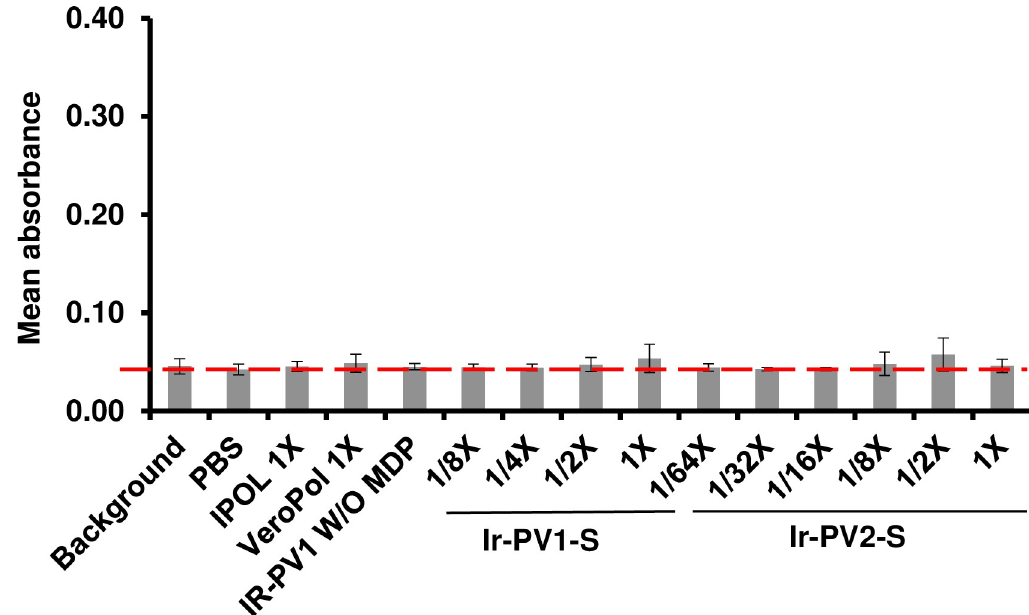
Fig 6. ELISA analysis of Wistar rat sera for MDP peptide reactivity. Sera from immunized rats were tested for anti-peptide antibodies using 96-well plates, which were coated with 5 ng DP1. Mean absorbance values of quadruplicate wells were plotted with standard deviations (mean values from 8 biological replicates per group). Values from wells probed without sera (Background or baseline, indicated with a red dotted line) or sera from rats immunized with either PBS, a 1 × human dose of IPOL, VeroPol, or IR-inactivated PV1-S without MDP were included as controls. Mean absorbance values from wells probed with sera from Wistar rats immunized with indicated doses of PV1-S and PV2-S are shown here. No significant differences were observed between any of the groups tested above. Ir-PV1-S and Ir-PV2-S, gamma irradiated PV-S.